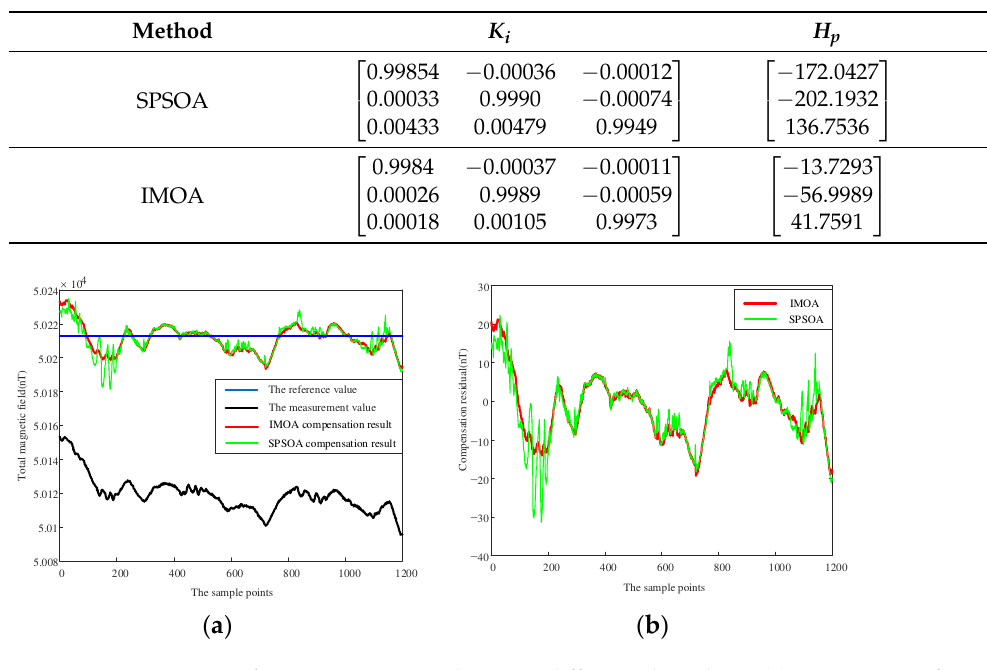
Figure 9. Comparison of compensation results using different algorithms: ( a ) comparison of total magnetic field before and after compensation; and ( b ) residual comparison after compensation.